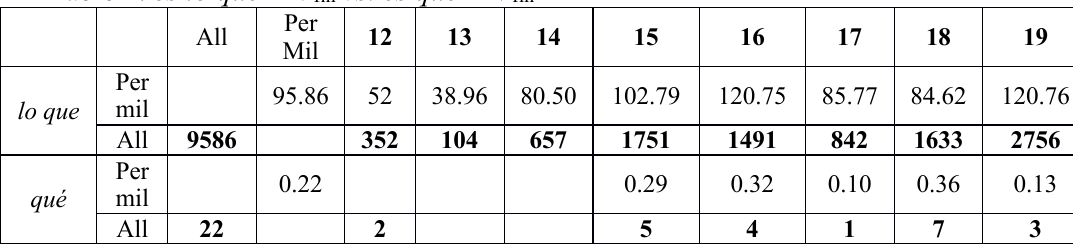
Table 1: es lo que + V